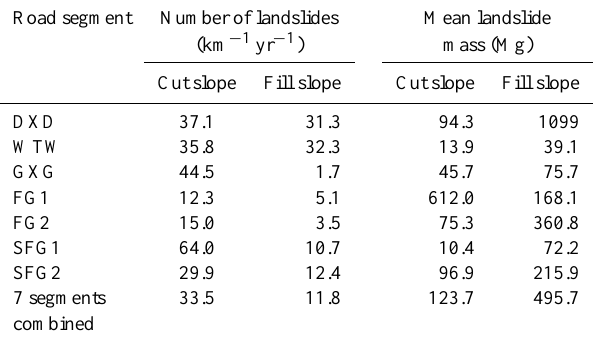
Table 2. Comparison of numbers and mean mass of landslides along cut and fill slopes of the seven monitored road